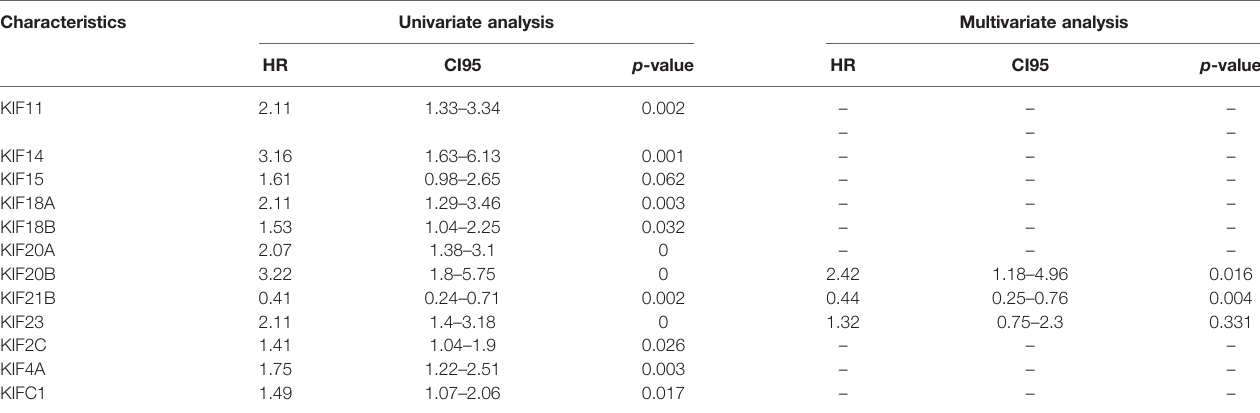
TABLE 3 | Univariate and multivariate analyses of prognosis-related KIFs. Characteristics Univariate analysis Multivariate analysis HR CI95 p -value p